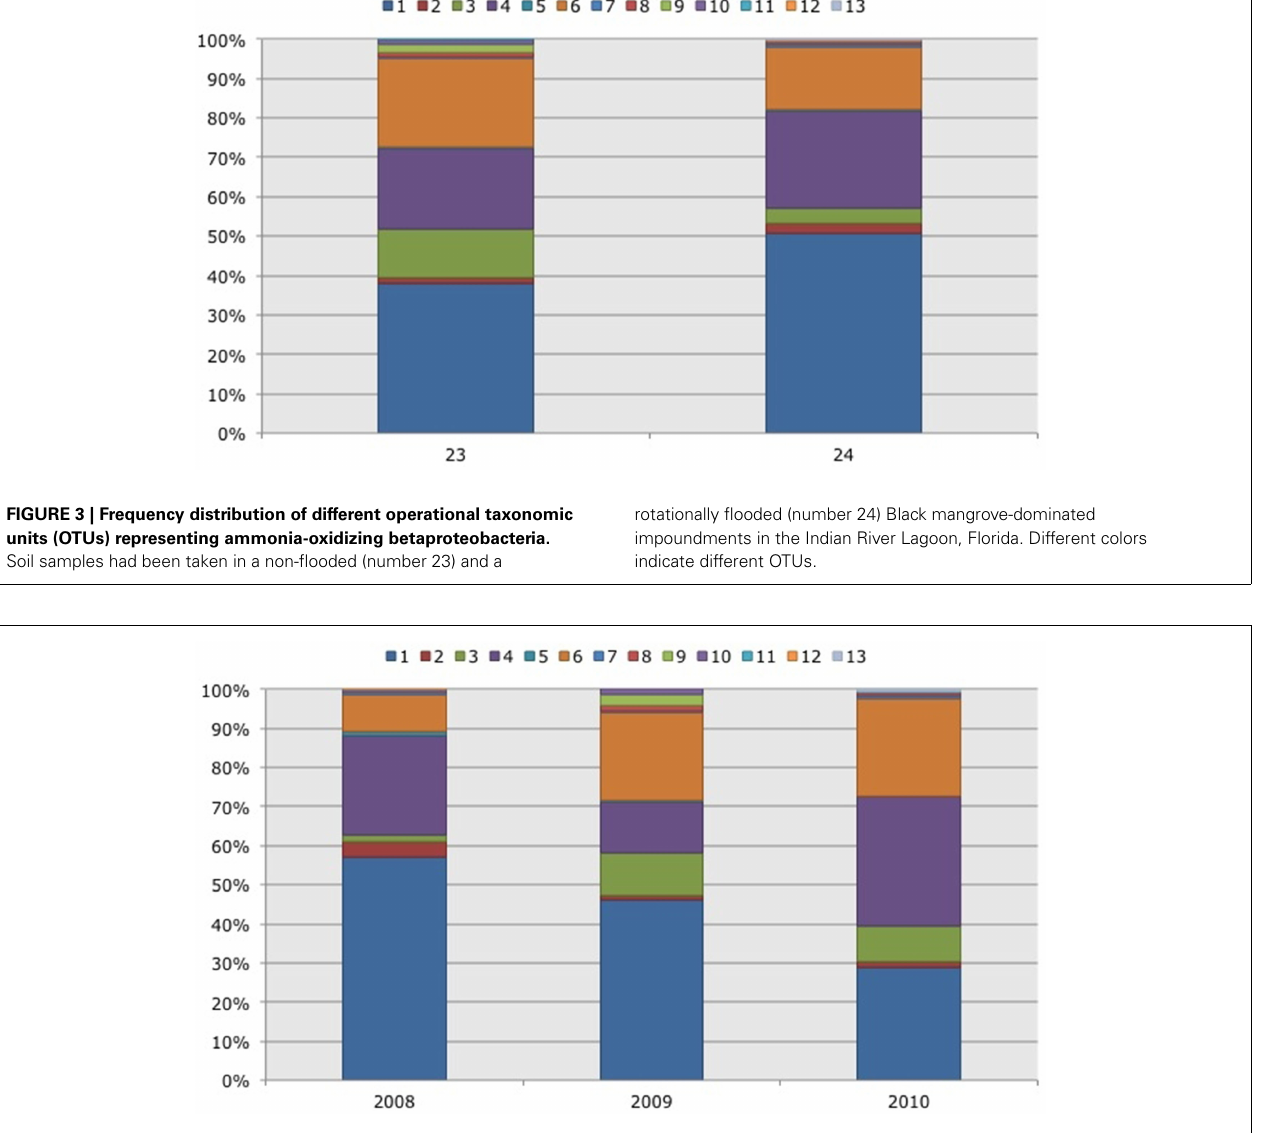
years (2008–2010) in two Black mangrove-dominated impoundments in the Indian River Lagoon, Florida. Different colors indicate different